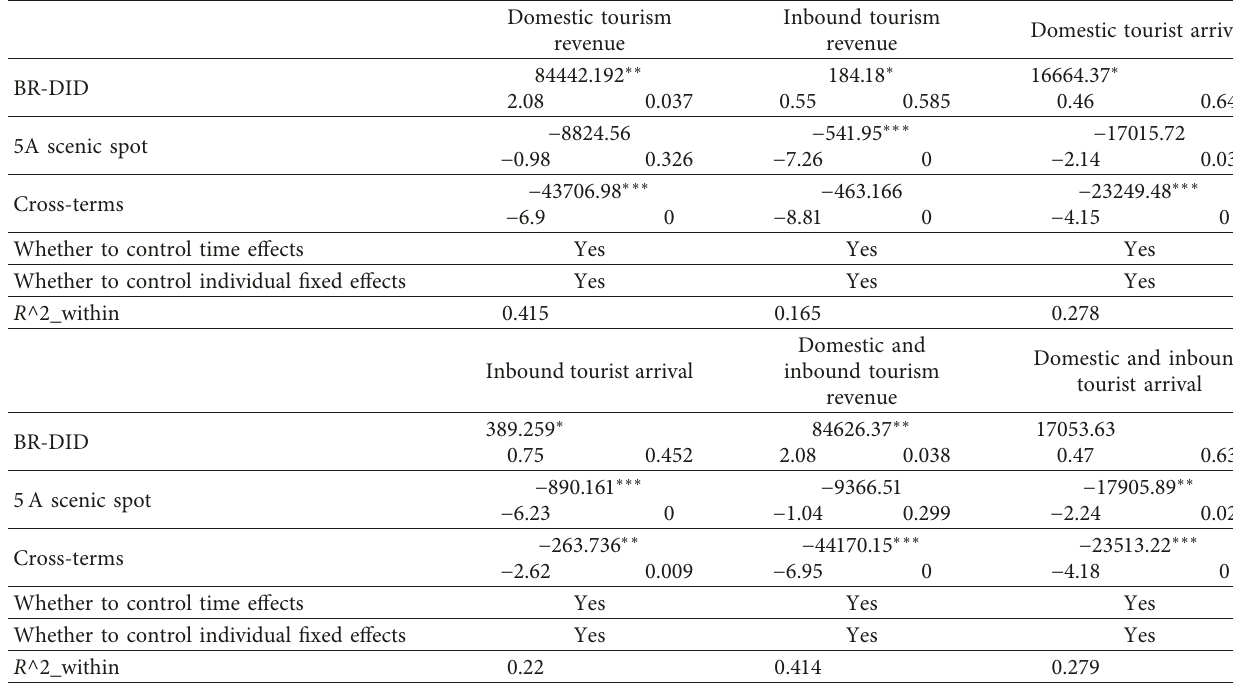
Table 5: Regression results of cross-terms between 5A scenic spots and “one belt, one road”